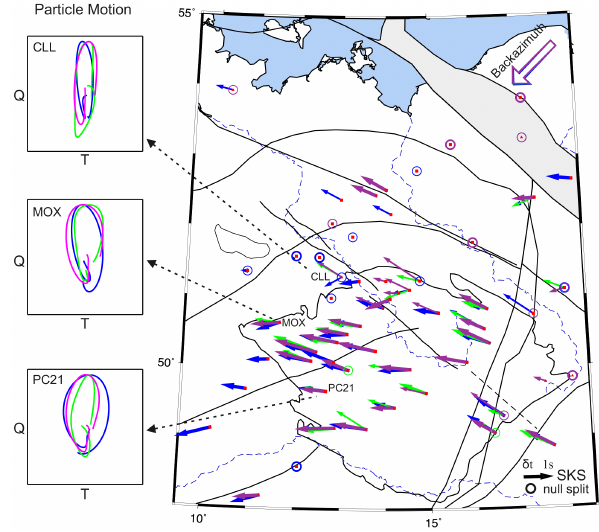
Figure 12. Shear-wave polarizations evaluated at a part of the PASSEQ array from recordings of three events. Splitting parameters evaluated from narrow PM of waves arriving from very close direc- tions differ at station CLL, while we get identical splitting parame- ters from the broad PM at e.g. station PC21. Complex structures can affect significantly the splitting parameters of waves arriving even from very close